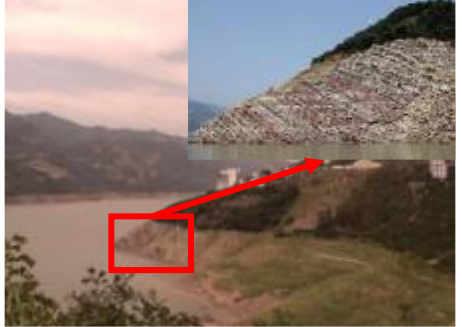
Figure 12. The study area with a measurement scale of 100 m.